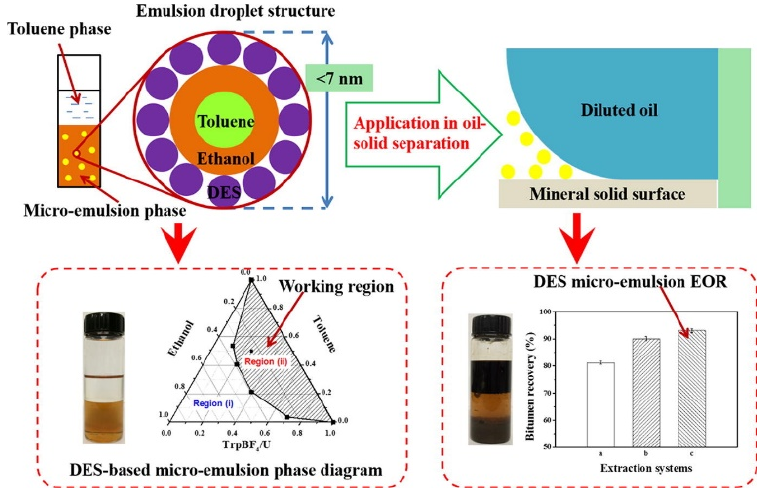
Figure 17. Application of amino acid ionic liquid-based deep eutectic solvent (TrpBF 4 /U) in UHO separation. Reprinted with permission from Ref. [43]. Copyright 2018, copyright the Elsevier. More details on Copyright and Liscensing are available via the following link: https://linkinghub.elsevier.com/.